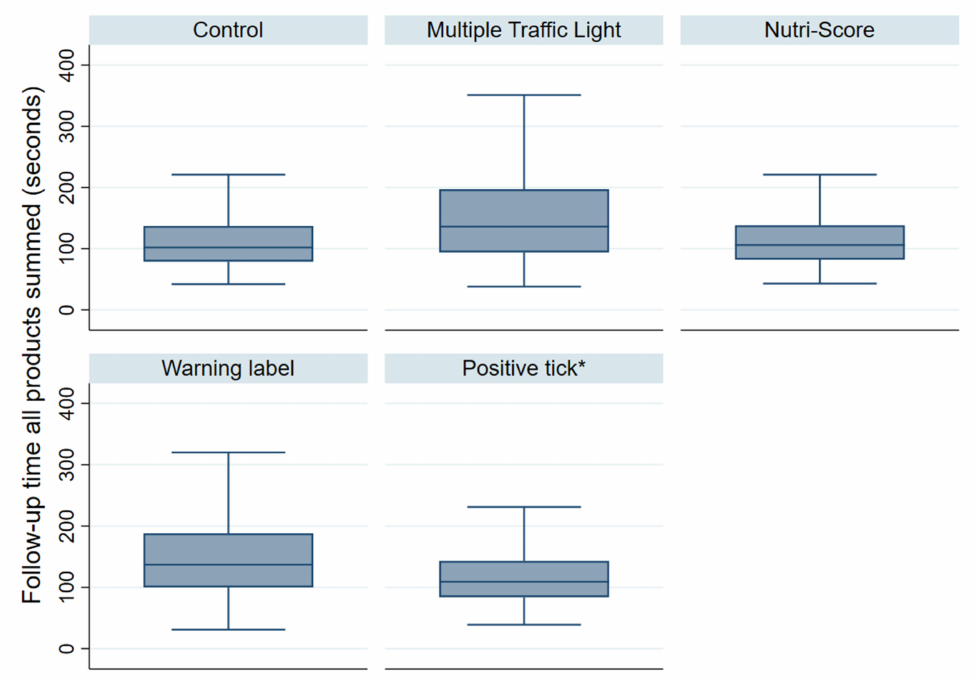
Figure 2. Median and interquartile ranges of ranking times (seconds) of summed follow-up rankings by experimental condition, excluding participants who did not have full covariate information and outliers. * Cake and crisps categories had no products qualify for Positive Choice tick; outliers not presented in the